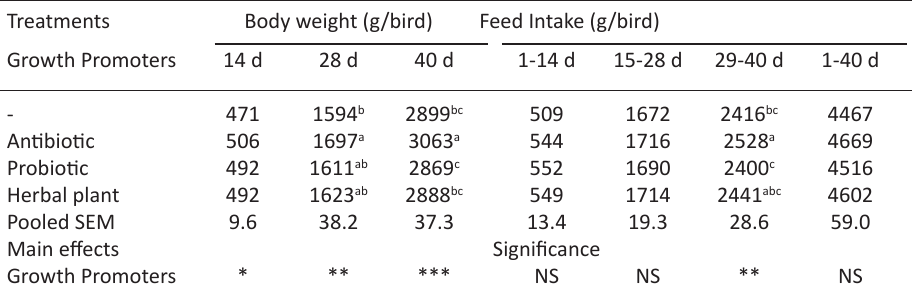
Table 2. Effects of different growth promoters on body weight and feed intake of Broilers 1 (1-40 days of age) Treatments